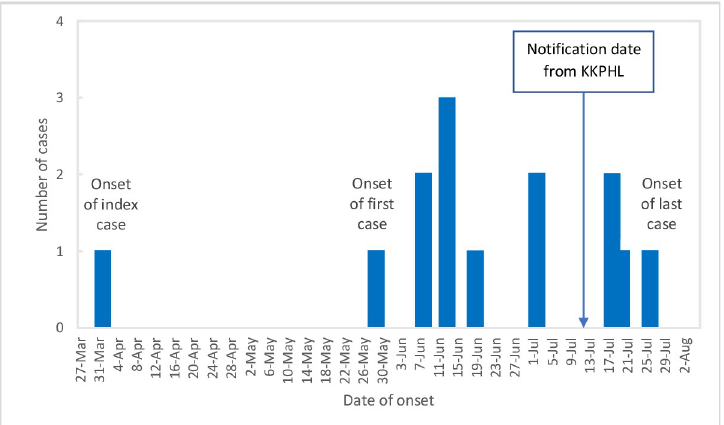
Fig 1. Epidemic curve. Epidemic curve of the Plasmodium malariae outbreak in Sonsogon Paliu village, Kota Marudu district, Sabah, Malaysia during July–August 2019. The numbers of cases are plotted against the day of occurrence of